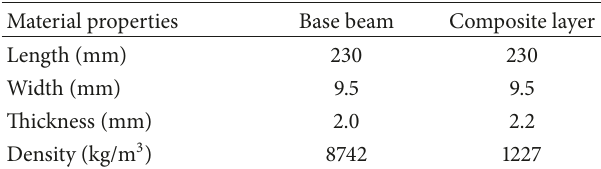
Table 1: Material and geometrical properties of the